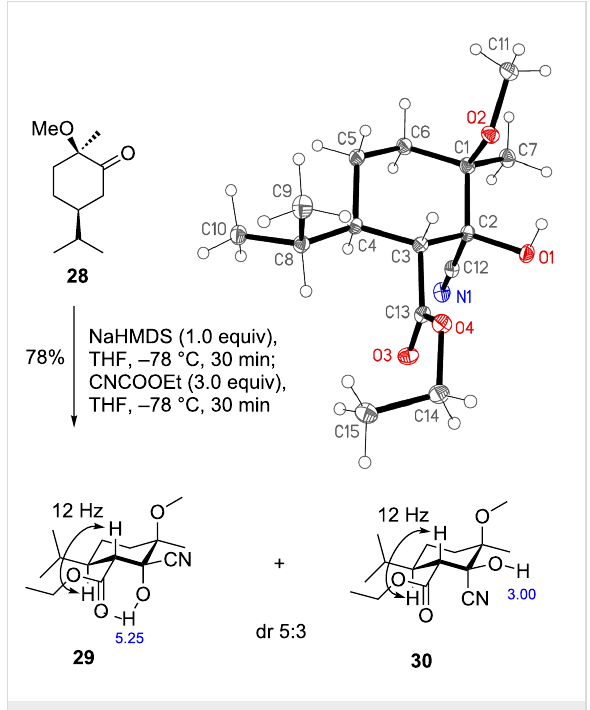
Scheme 4: Structure analysis of diastereomeric cyanohydrins 29 and 30